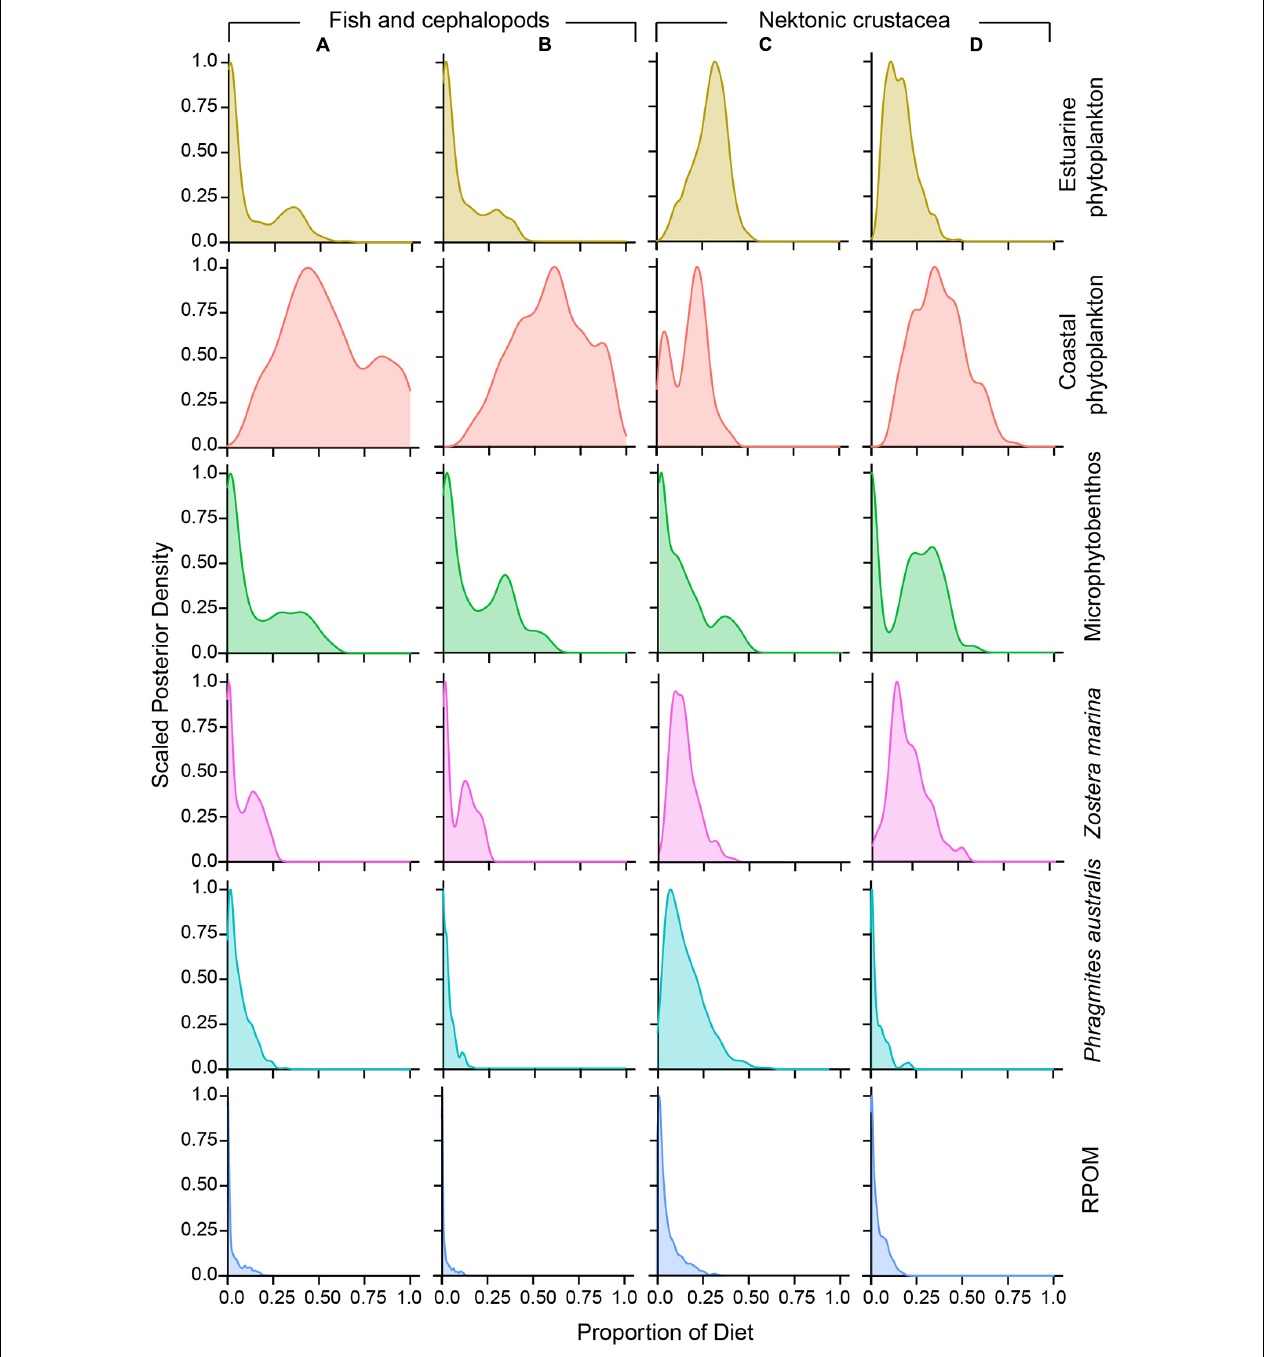
FIGURE 6 | Scaled posterior density of the proportions of the contribution of putative primary organic matter sources fueling the estuarine channel (EC; A,C ) and deep-bay and offshore (DB and OS sites; B,D ) nekton communities.